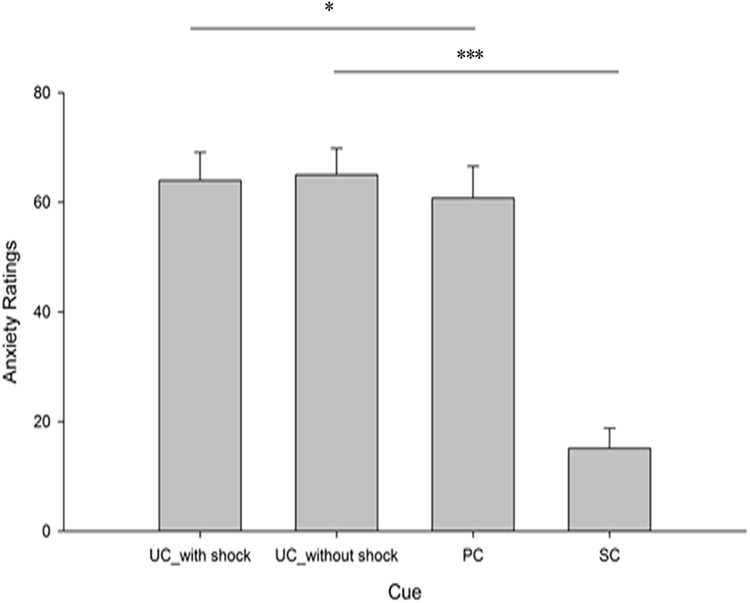
Mean subjective anxiety level ratings for cues (UC-with shock, UC-without shock, PC, SC).The x-axis indicates independent variables: UC-with shock, UC-without shock, PC versus SC. The y-axis indicates the mean anxiety level ratings by all subjects (mean±S.E.). Error bars depict the standard errors.